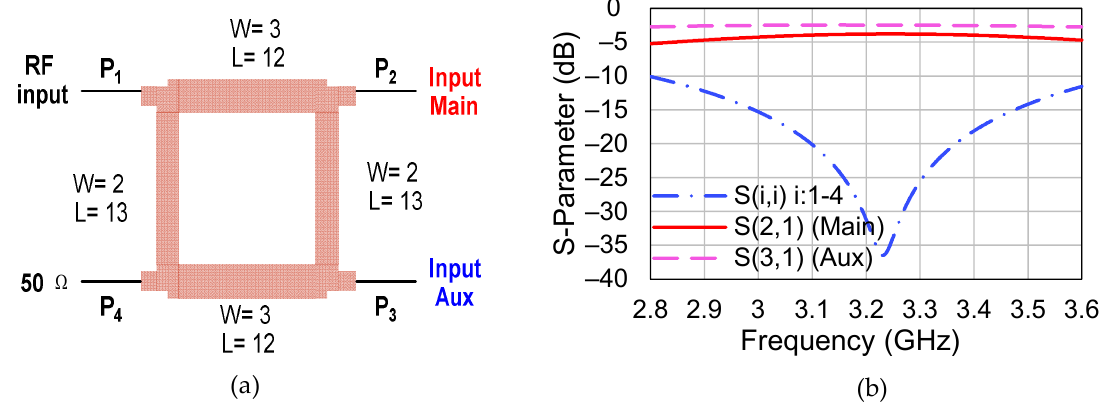
Figure 8. ( a ) Layout of the splitter (dimension: width/length (mm)). ( b ) Performance versus